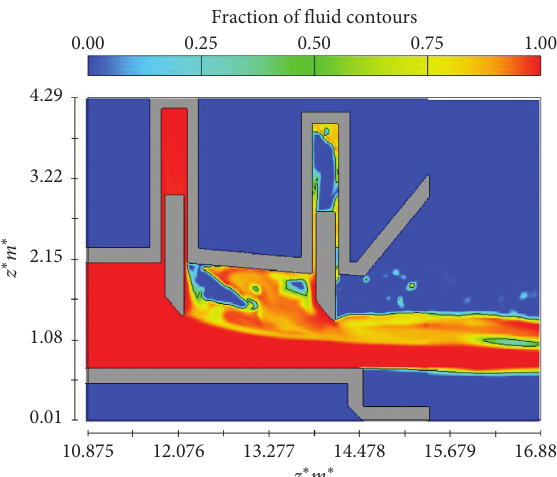
Figure 26: Fluid volume fraction contour between two gates in 50% opening state.